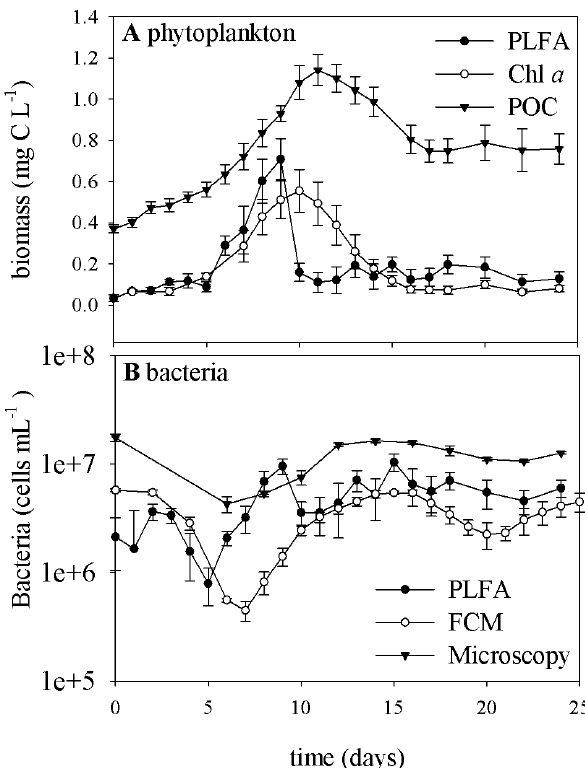
Fig. 3. Comparison of (A) phytoplankton biomass based on PLFA, Chl- a , and POC and (B) bacterial numbers based on PLFA, Flow Cytometry (FCM), and microscopy. Average and SD of all meso- cosms are